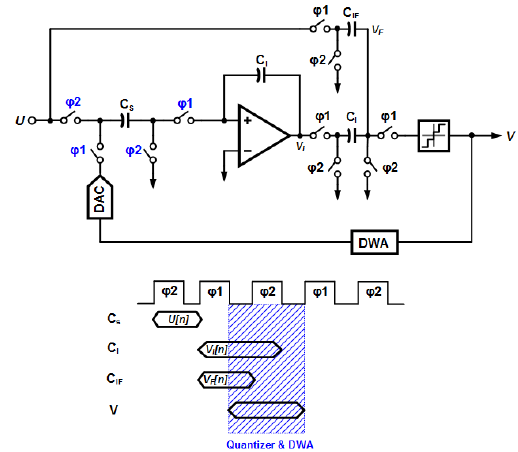
Figure 3. Proposed first-order switched capacitor circuit and its timing diagram [1].